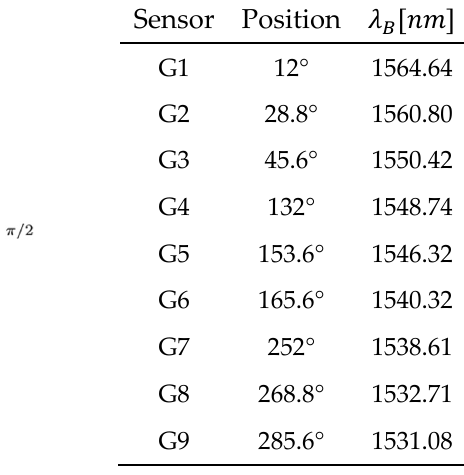
Figure 3. FBGs’ positions on the cylinder surface (graph on the left) and wavelengths (table on the right). Sensors are numbered from 1 to 9 following the radial coordinate from 12° to 285.6°.